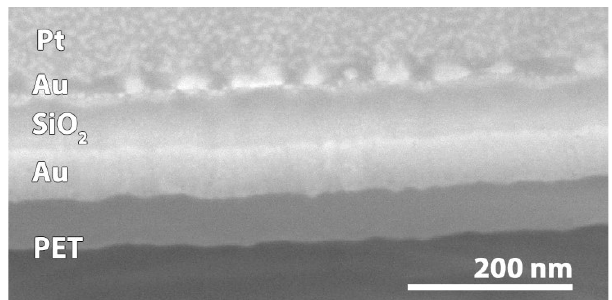
Figure 7. Cross-sectional SEM image of TiO 2 /Au/PET model sample b.